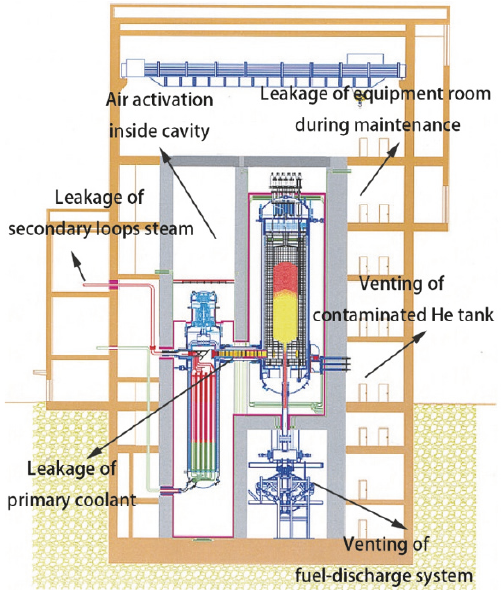
Figure 6: Airborne radioactivity sources of HTR-PM